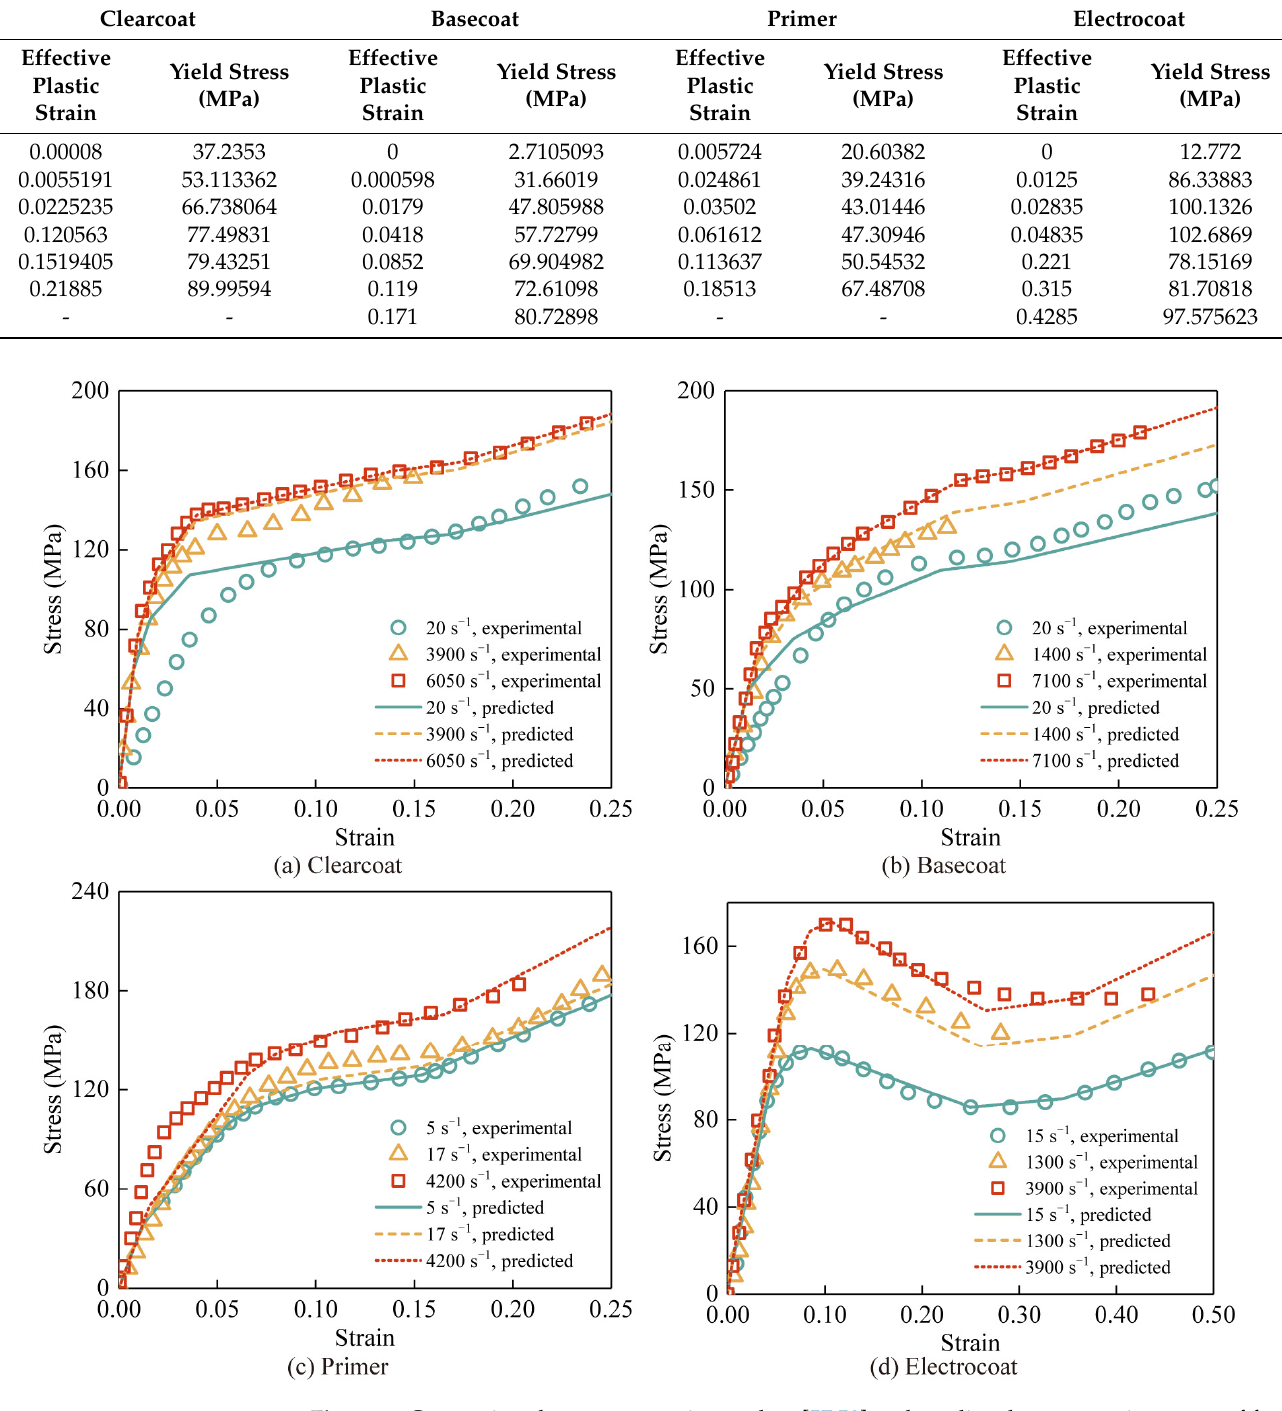
Table 4. The yield-stress-effective plastic strain data of each paint film.